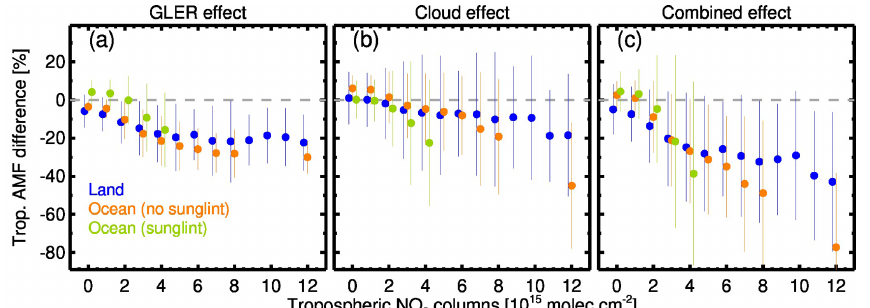
Figure 6. The impact on tropospheric AMF (i.e., V4.0–V3.1) from changes in (a) surface reflectivity, (b) cloud, and (c) their combination for clear and partially cloudy scenes (CRF < 0.5) on 20 March 2005. Percent differences in tropospheric AMF are sorted by tropospheric NO 2 columns, separating them by land (blue) and ocean, as well as by sun-glint (green) and non-sun-glint (orange) geometry over ocean. The vertical bars represent the standard deviations for the tropospheric NO 2 column bins.